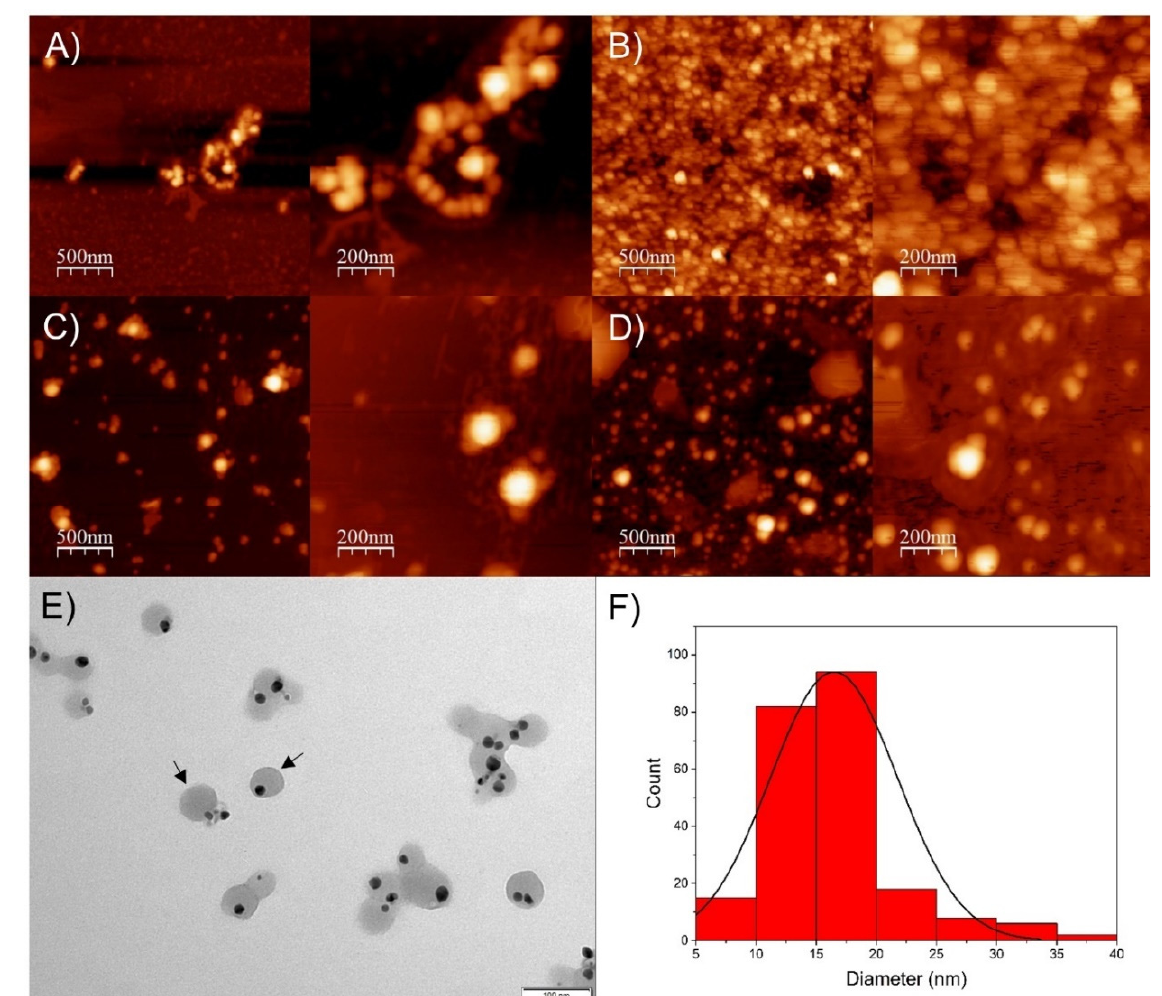
Figure 3. Atomic force microscopy and transmission electron microscopy of seasonal samples of SP-AgNPs. ( A ) Spring SP-AgNPs; ( B ) Summer SP-AgNPs; ( C ) Autumn SP-AgNPs; ( D ) Winter SP-AgNPs; ( E ) TEM image of winter SP-AgNPs, and ( F ) histogram of winter SP-AgNPs from TEM images. Black arrows: SP-AgNPs surrounded by propolis extract.